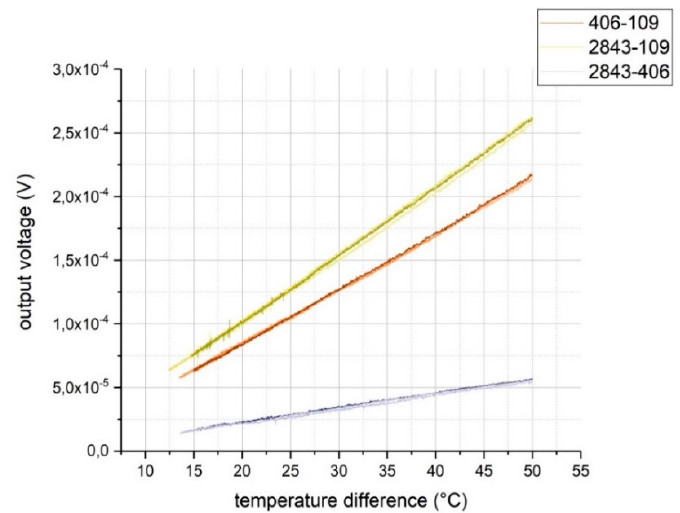
Figure 6. Output voltages of thermocouples 406-109, 2843-109, and 2843-406 as functions of temperature difference between junction and connections; four measurement cycles per thermocouple.